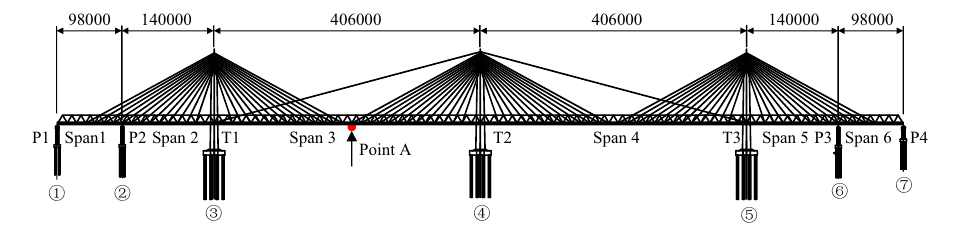
Fig. 4 Overall arrangement of the bridge